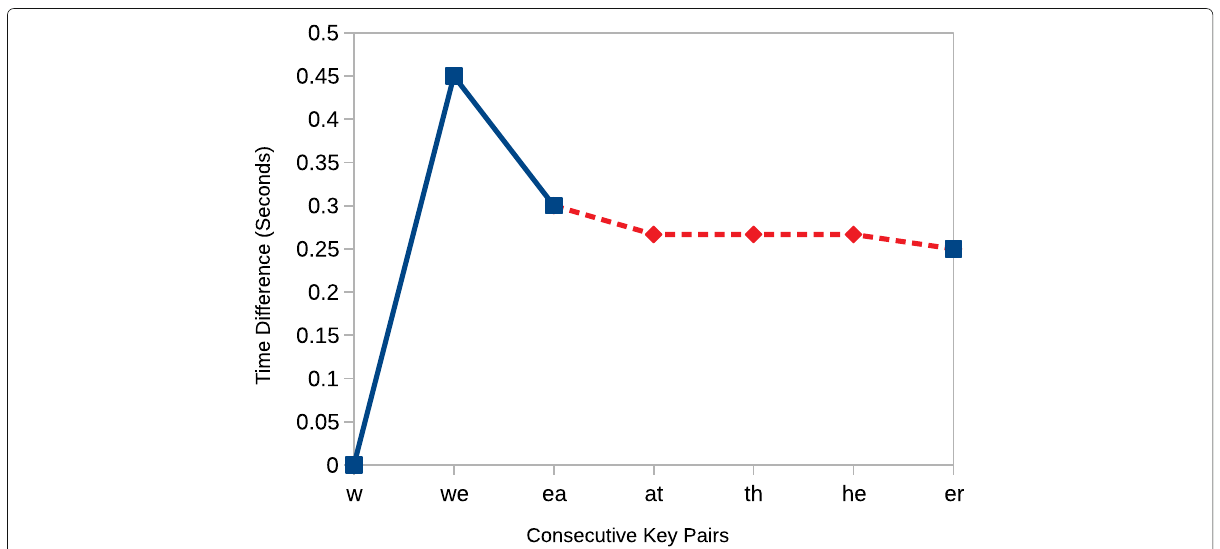
Fig. 5 Incompletely captured T 2 example (artificial data) with raw timestamps for “t” and “h” omitted. The time difference values calculated following the interpolation process are shown through the dashed line